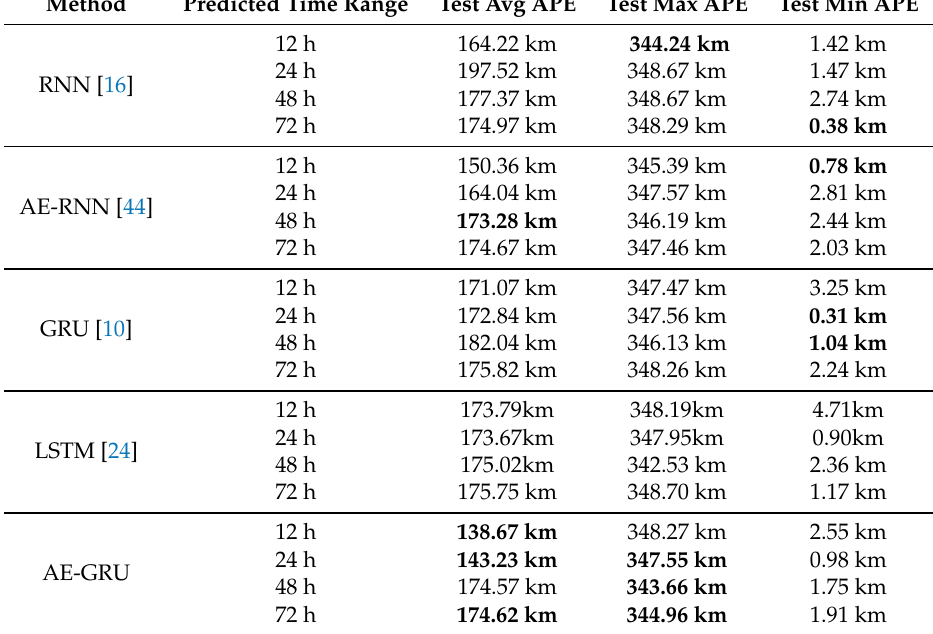
Table 5. Comparison results among RNN, AE-RNN, GRU, and